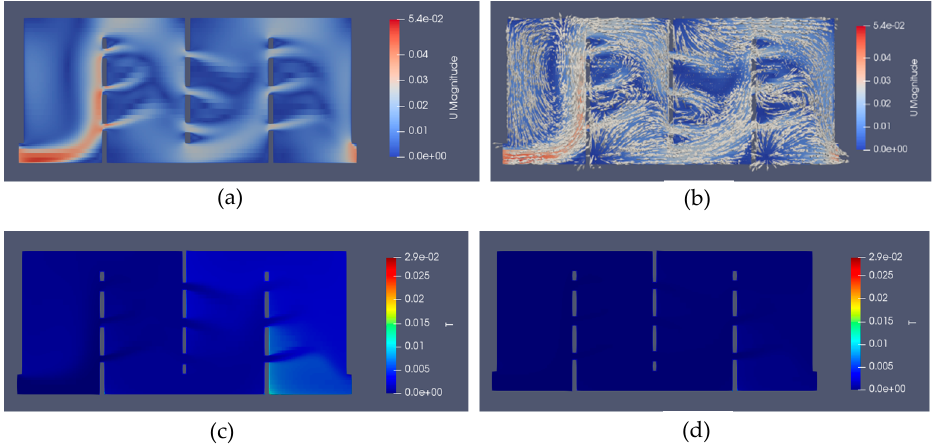
Figure 9. Typical velocity magnitude and concentration distributions in the contact tank with finite with slots (w = 120 mm, h = 10, 12, 14 mm random) case: ( a ) Flow distribution; ( b ) Flow distribution with velocity vectors; ( c ) Concentration distribution at 200 s; ( d ) Concentration distribution at 300 s.